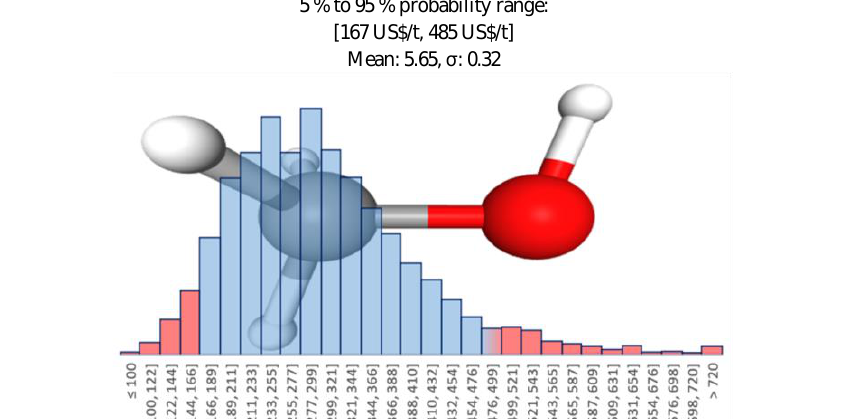
Figure 11. Ethanol and methanol individual price Log-Normal distributions used in the Monte-Carlo